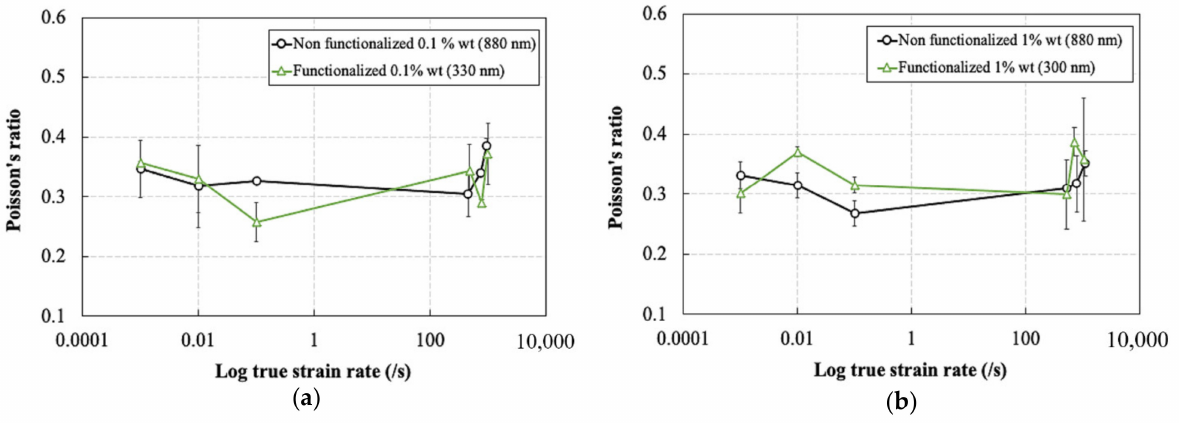
Figure 14. Effect of silica nanoparticles size and surface functionalization on the Poisson’s ratio for the silica nanoparticle: ( a ) 0.1% and ( b )